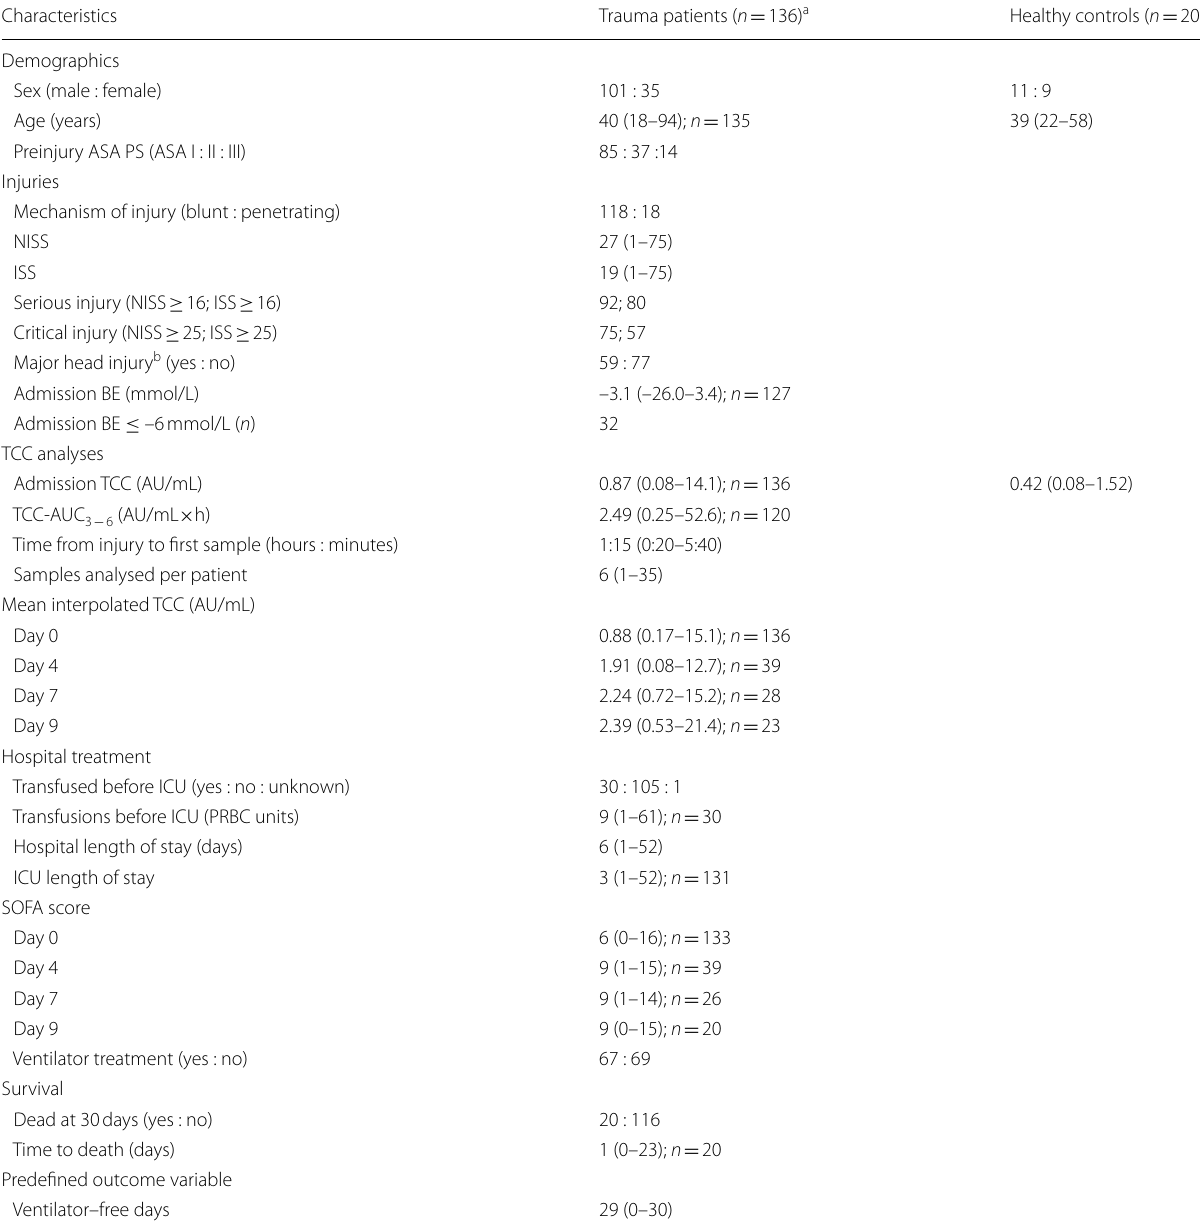
Table 1 Characteristics of study population and